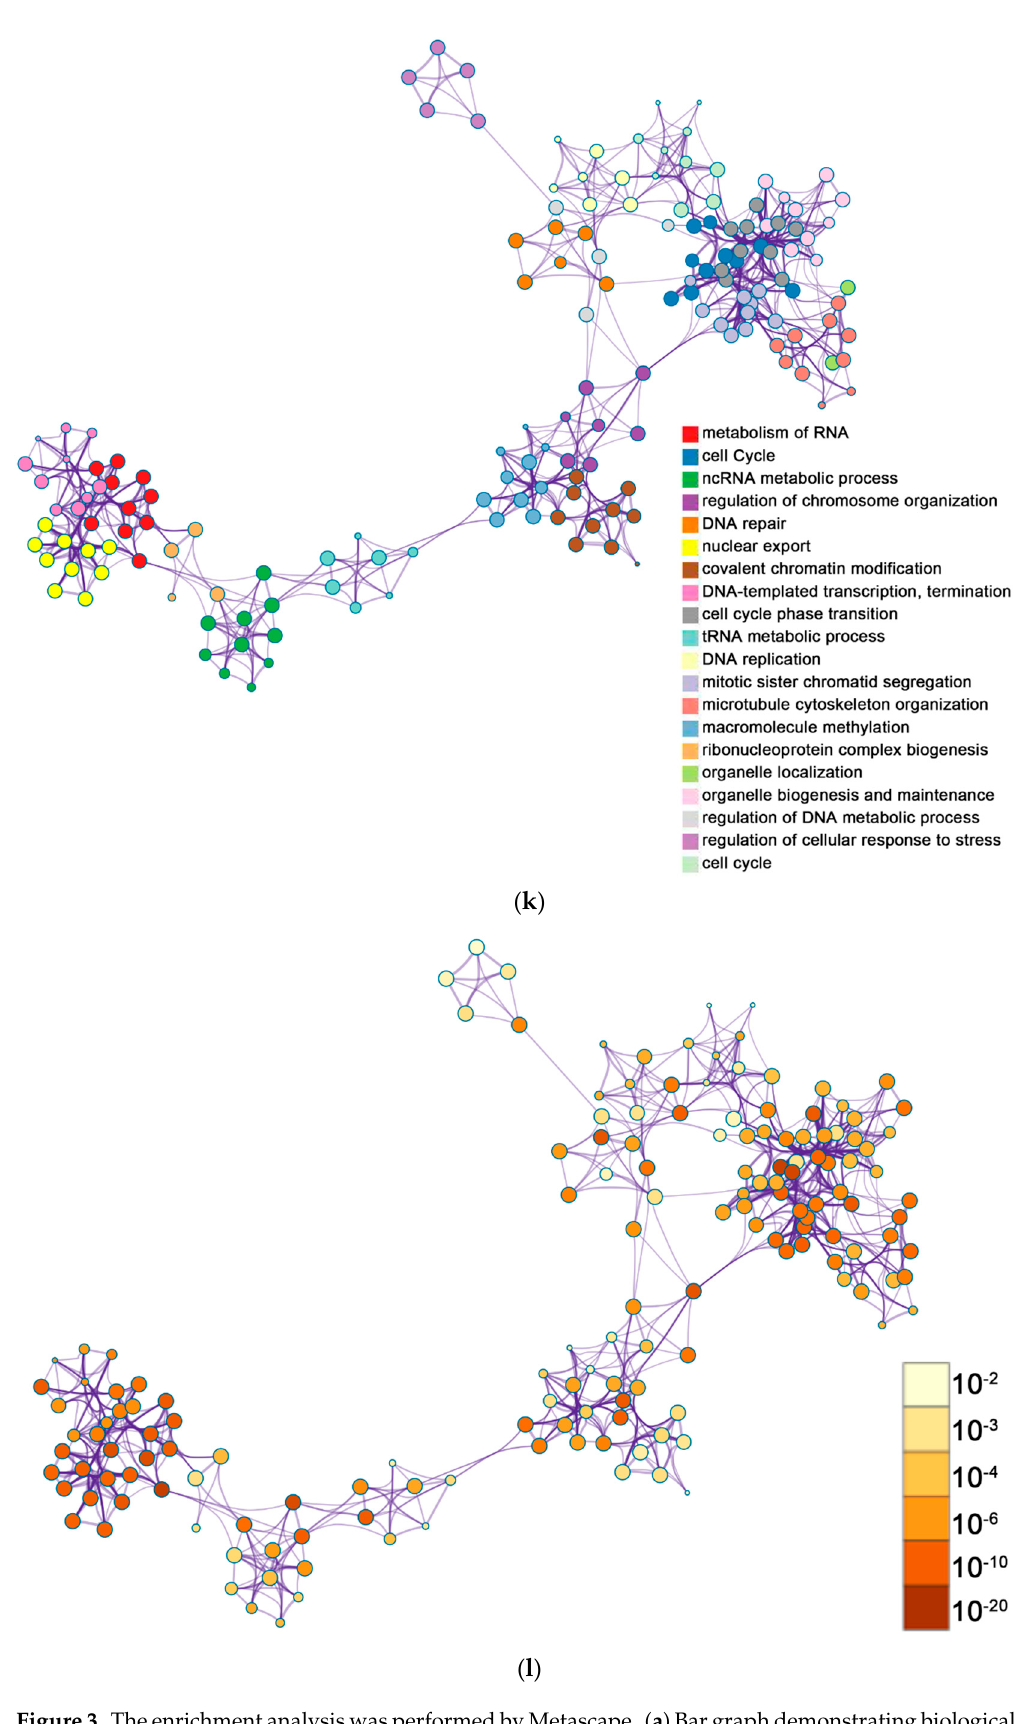
Figure 3. The enrichment analysis was performed by Metascape. ( a ) Bar graph demonstrating biological processes enrichment analysis of up-regulated genes of group 1. For down-regulated genes of group 1, Metascape only visualized the top 15 clusters by their colors. Enriched terms were identified